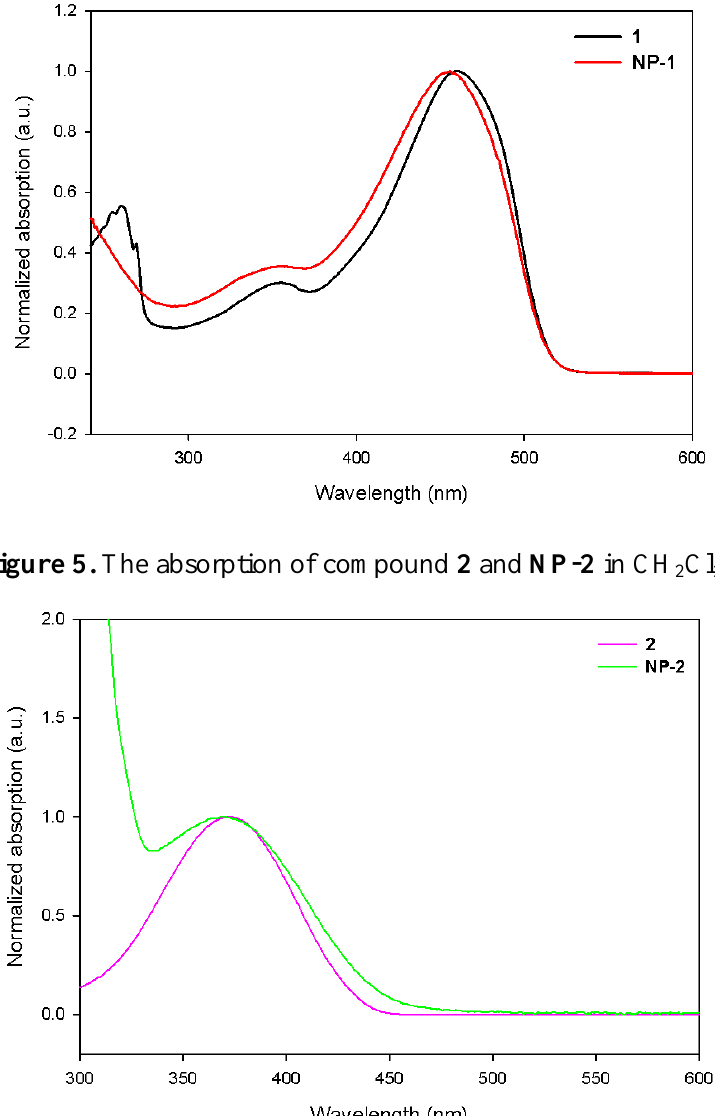
Figure 4. Absorption spectra of compound 1 and NP-1 in CHCl